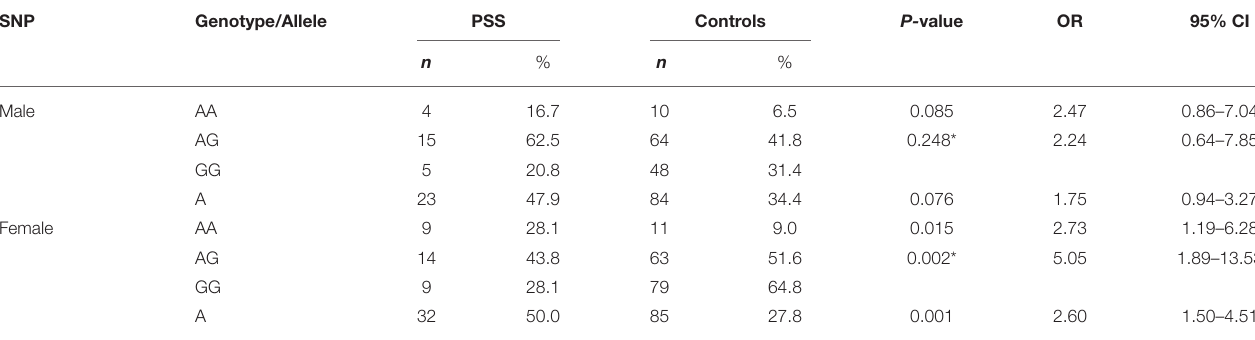
TABLE 4 | Polymorphisms of CFH -rs800292 in PSS patients and healthy controls stratified by gender.